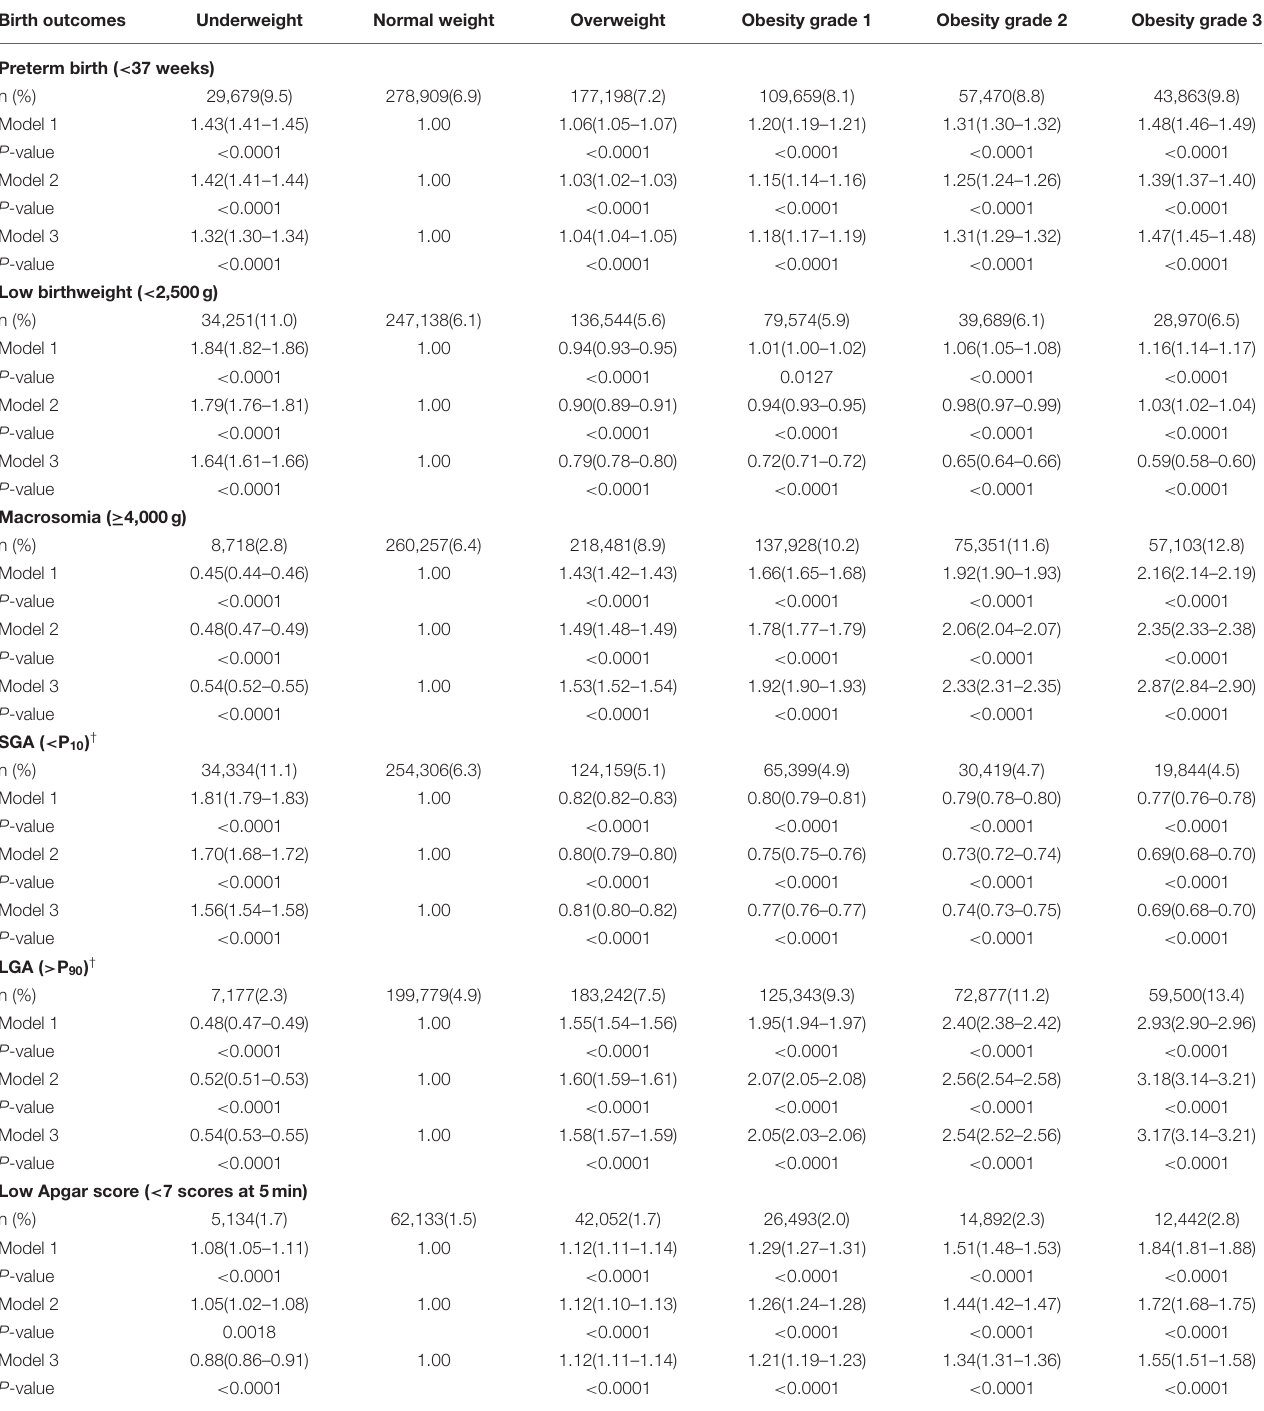
TABLE 2 | Odds ratios and 95% CIs of infant birth outcomes according to maternal prepregnancy BMI